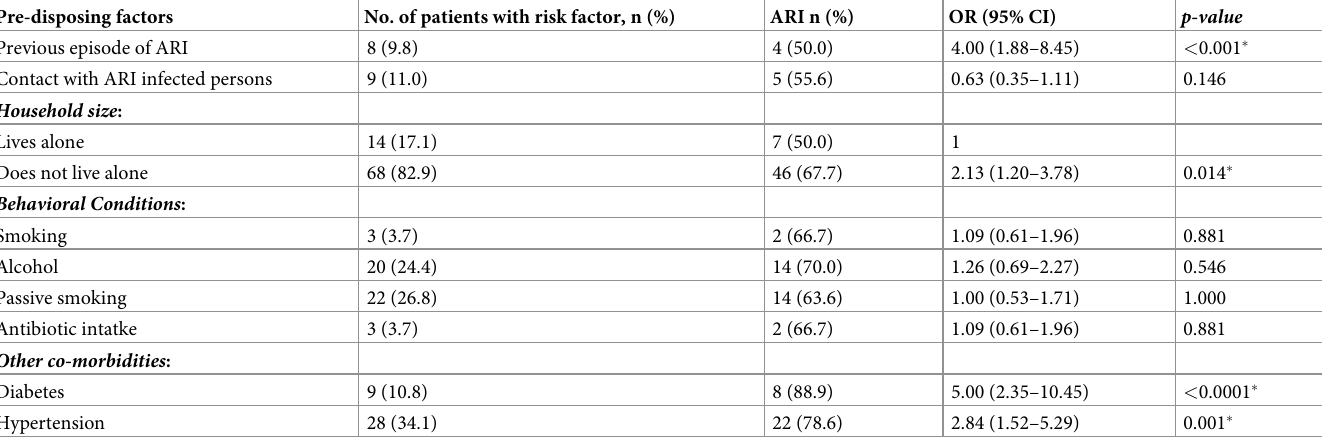
Table 6. Pre-disposing factors associated with ARI among the